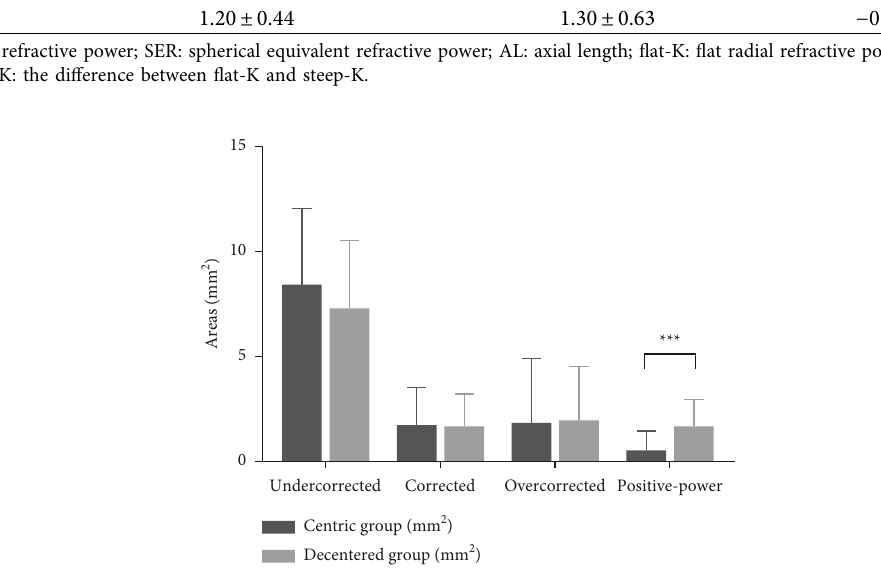
Figure 3: Comparison of the distribution of different refractive power areas between the centric group and decentered group ( ∗∗∗ p < 0 . 001).